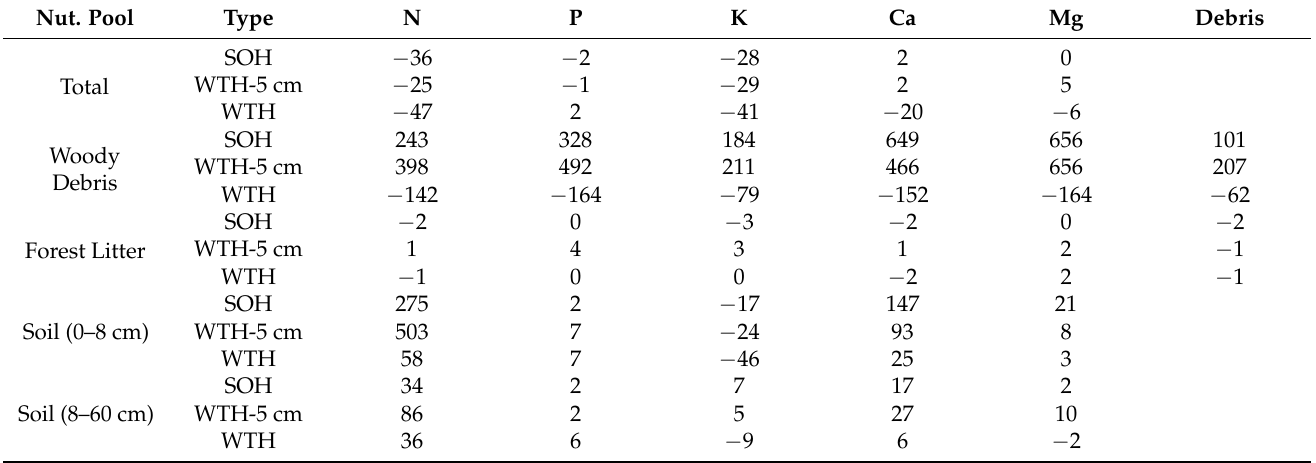
Table 3. Percent change from the unharvested site compared to observations at 93 months normalized by the difference between the control groups. The total pool shows decreases in N and K across treatments, and Ca declines in the WTH. The largest differences were in the woody debris and soil pools. Unharvested site information can be found in table 11